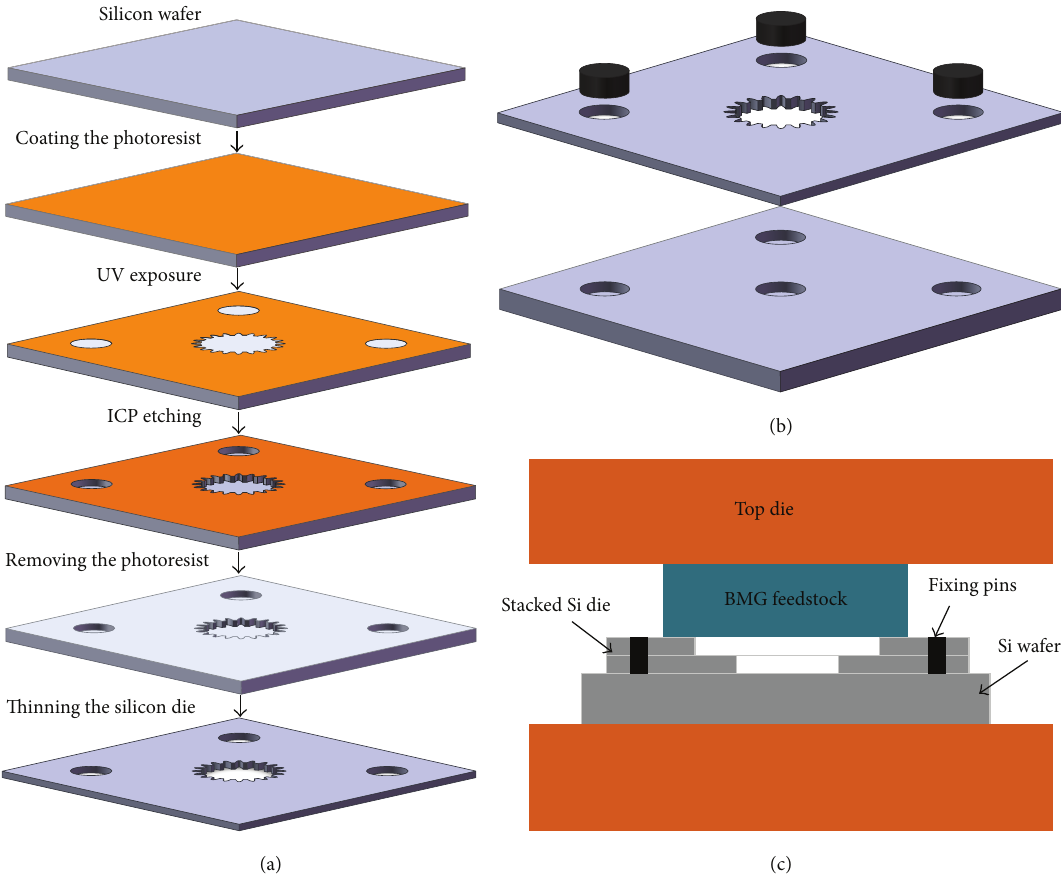
Figure 1: Sketches of silicon dies preparation (a), silicon dies stacking (b), and hot embossing process